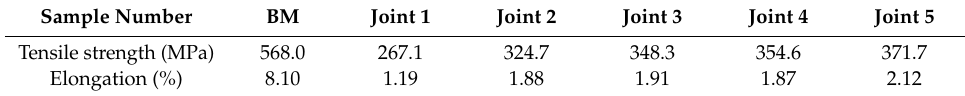
Table 2. Results of tensile tests of welded joints and base metal